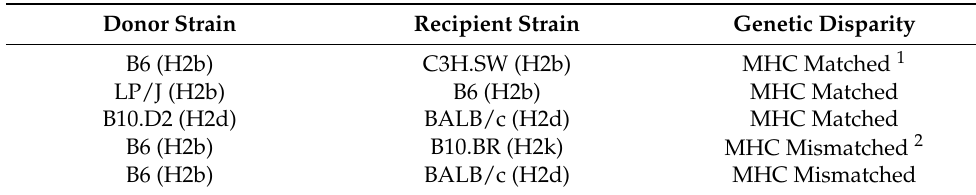
Figure 1. Schematic and clinical scoring features of ocular and cutaneous involvement in graft vs. host disease. ( A ) Clinical photos from patient with GVHD with corneal keratopathy (as demonstrated with fluorescein staining) and sclerodermal skin changes characterized by the thickening and induration of the cutaneous epithelium. ( B ) Schematic of ocular changes characterized by lid swelling and closure and skin pathology as demonstrated by alopecia and decreased skin integrity and fur texture in pre-clinical HSCT models. ( C ) Skin and ocular scoring system parameters used in the GVHD models were adapted from Perez et al. [15] and Cooke et al. [27]. Table 1. Transplants performed to assess/examine the relationship between skin and eye involvement post-allo